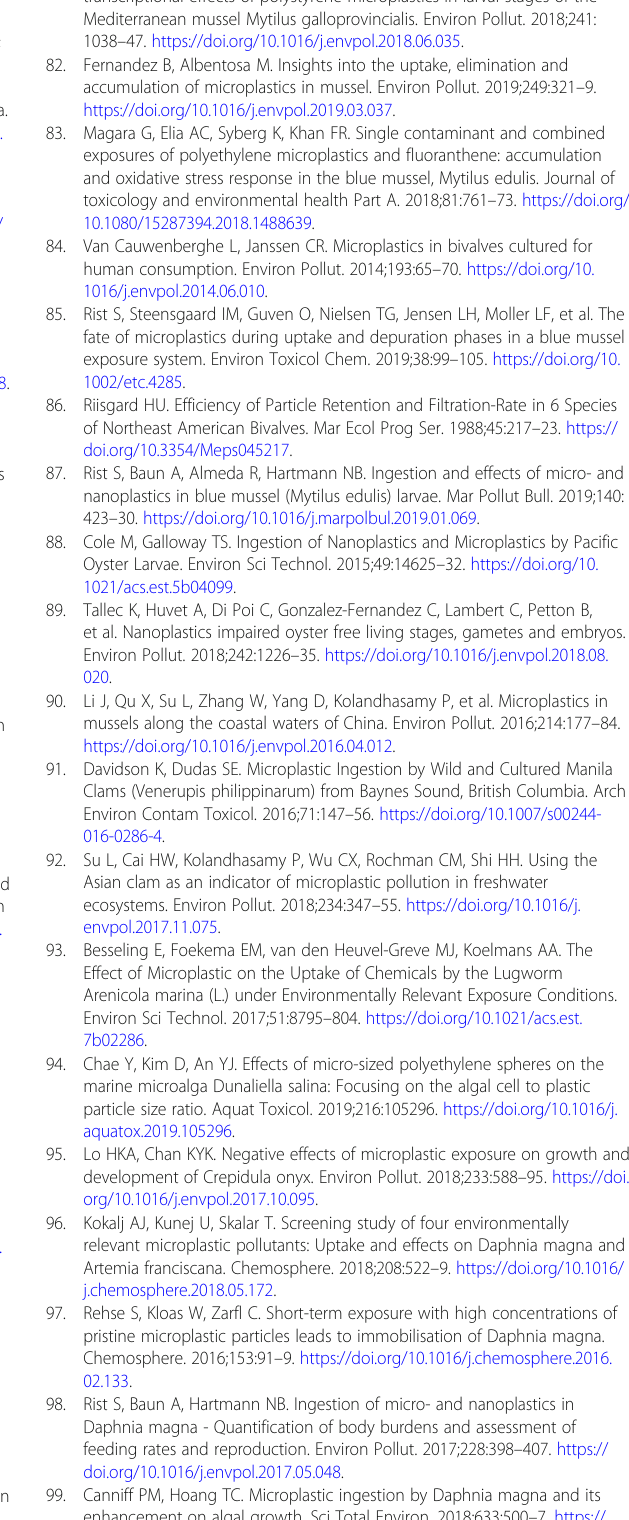
Table Salts from China. Environ Sci Technol. 2015;49:13622 – 7. https://doi.